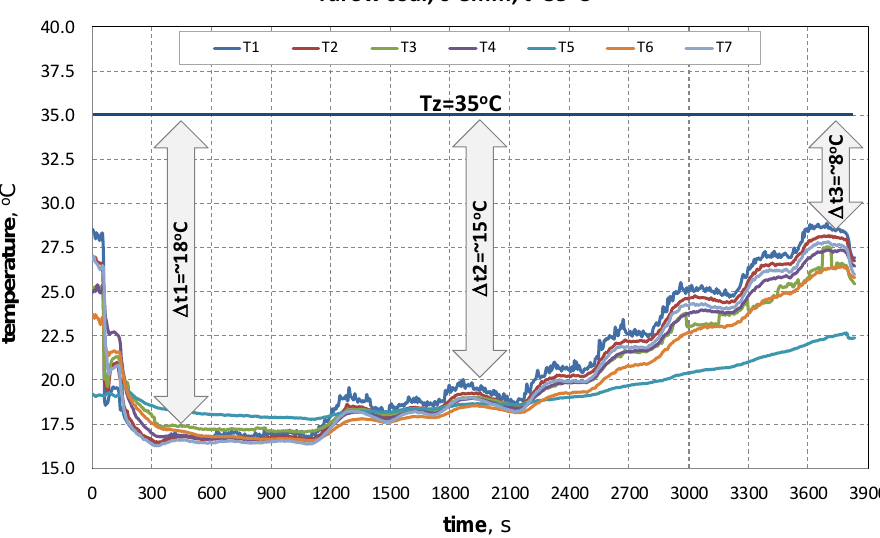
Figure 6. Sample chart of temperature in time at different levels of the bed, measured with seven temperature sensors (T 1-7) according to Figure 5b.